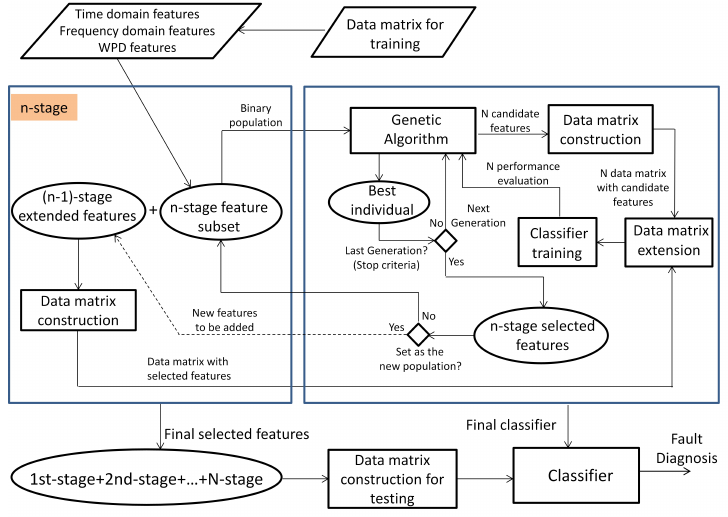
Figure 6. Multi-stage approach for feature selection in fault